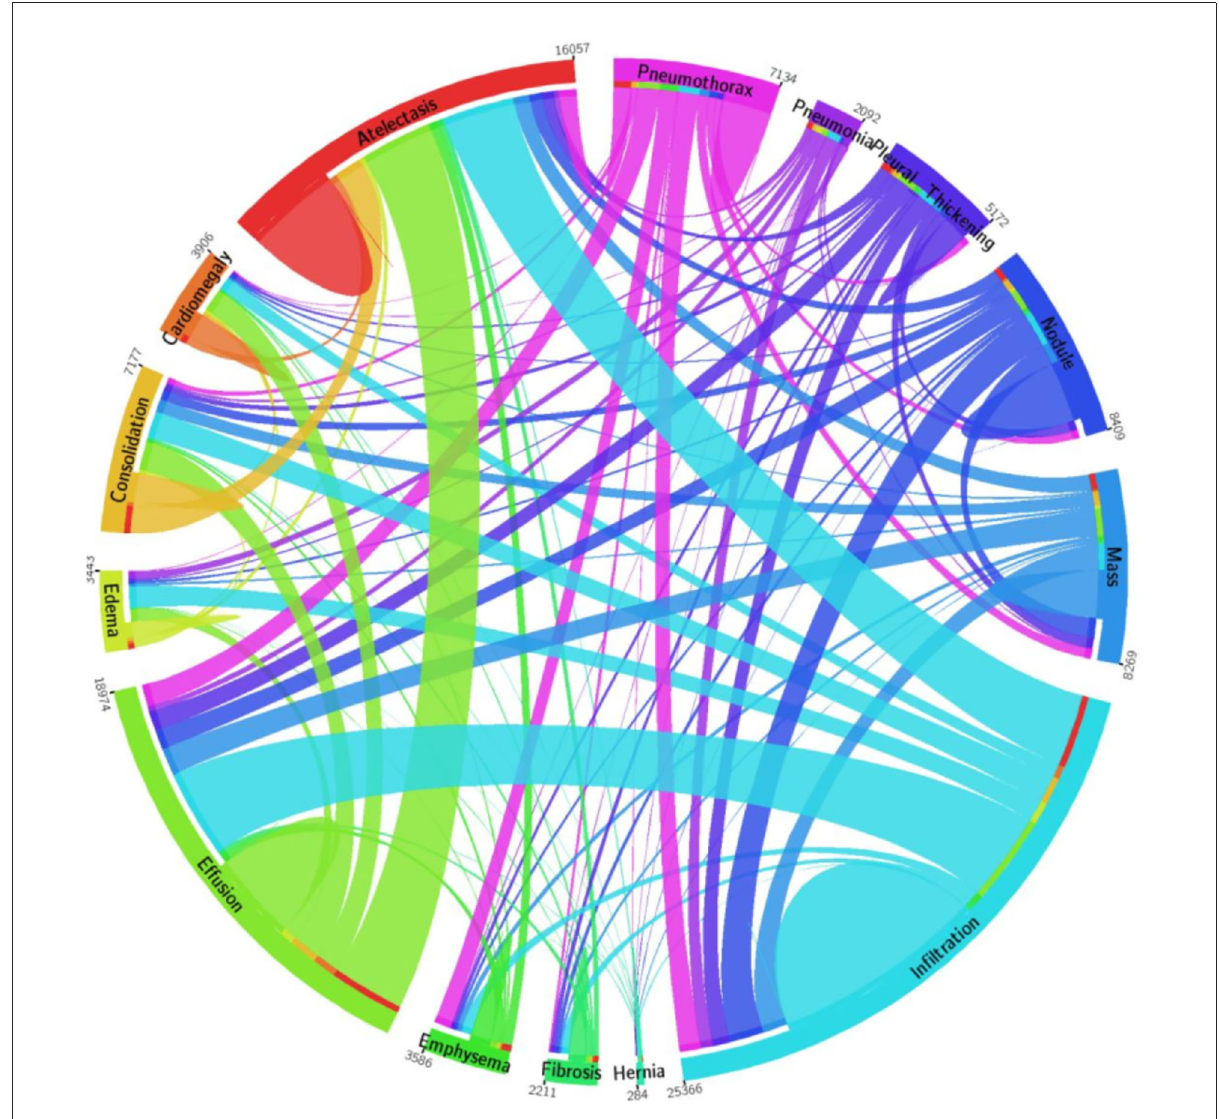
FIGURE4 A pictorial view of sample information from the NIH Chest X-ray dataset